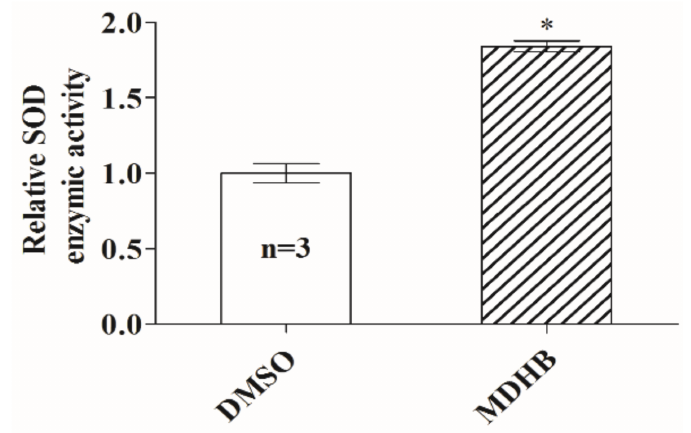
Figure 3. Effect of MDHB on superoxide dismutase (SOD) activity of wild-type C. elegans . Error bars represent the standard deviations (SD), and differences between the DMSO (control) and MDHB groups were described significant at * p < 0.05 by one-way ANOVA. This experiment was performed thrice.